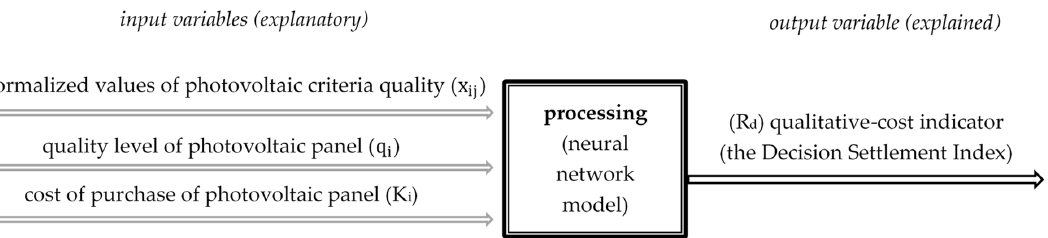
Figure 9. Simplified scheme of the neural network to sensitivity analysis of the proposed model. The model was carried out as part of multiple sampling, using a random sampling method. In order to increase the network’s ability to data generalization, according to the authors of articles [4,71], it was assumed: training sample (70%), test sample (15%), and validation sample (15%), number of samples equal to 2, and the initial generator value was 1000. The selection of the final neural network was based on multiple tests of differing models, for example, the number of neurons in the hidden layer or the type of activation function. Finally, the network type of multilayer perceptron (MPL) was selected [71]. It was the network of MPL 17 ‐ 15 ‐ 1 characterized by 17 input neurons, 15 hidden layer neu ‐